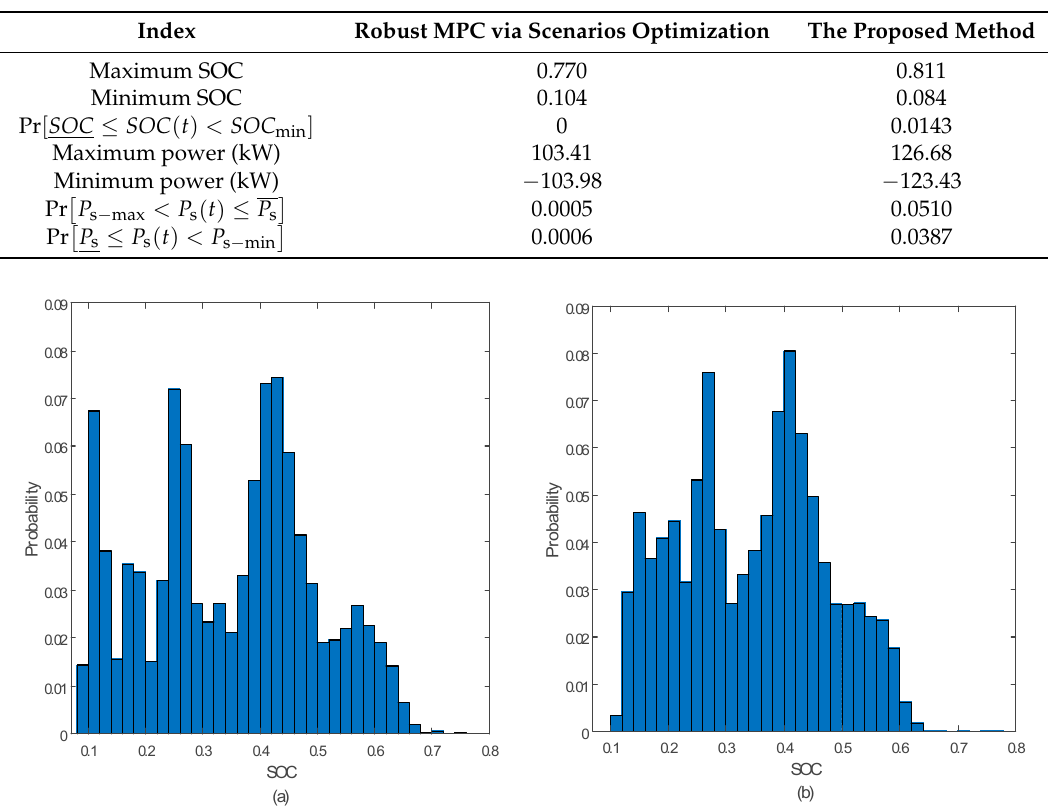
Figure 6. Comparison of probability distributions of SOCs. ( a ) The proposed method; and ( b ) Robust MPC via scenarios optimization.